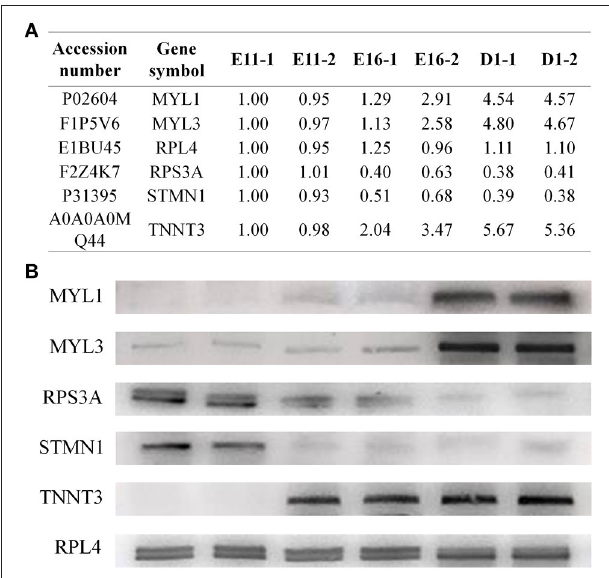
FIGURE 4 | Western blotting validation of the differentially expressed proteins. (A) The proteome data for candidate proteins. (B) Western blotting results showed that the expression levels of MYL1, MYL3, and TNNT3 all increased, while RPS3A and STMN1 decreased from E11 to D1. The protein RPL4 was used as reference